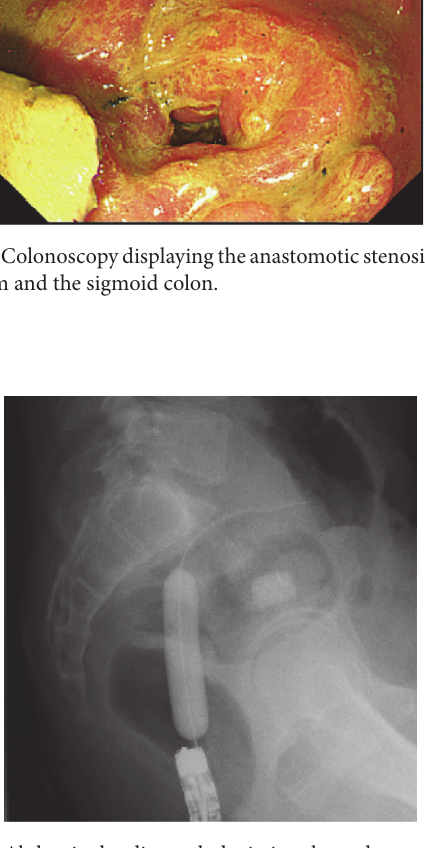
Figure 3: Abdominal radiograph depicting the endoscopic balloon dilatationforthestenoticlesionbetweentherectumandthesigmoid colon.